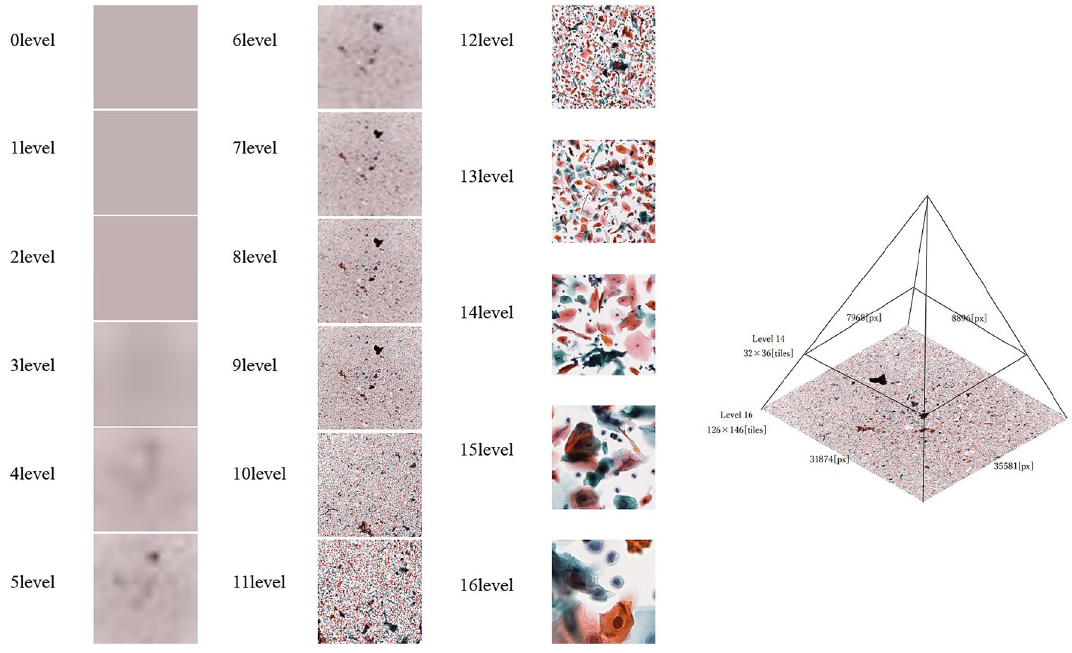
Figure 4. Automatic division of WSI using OpenSlide. Images can be acquired from different depth levels. In this study, images with a depth of 14th level were